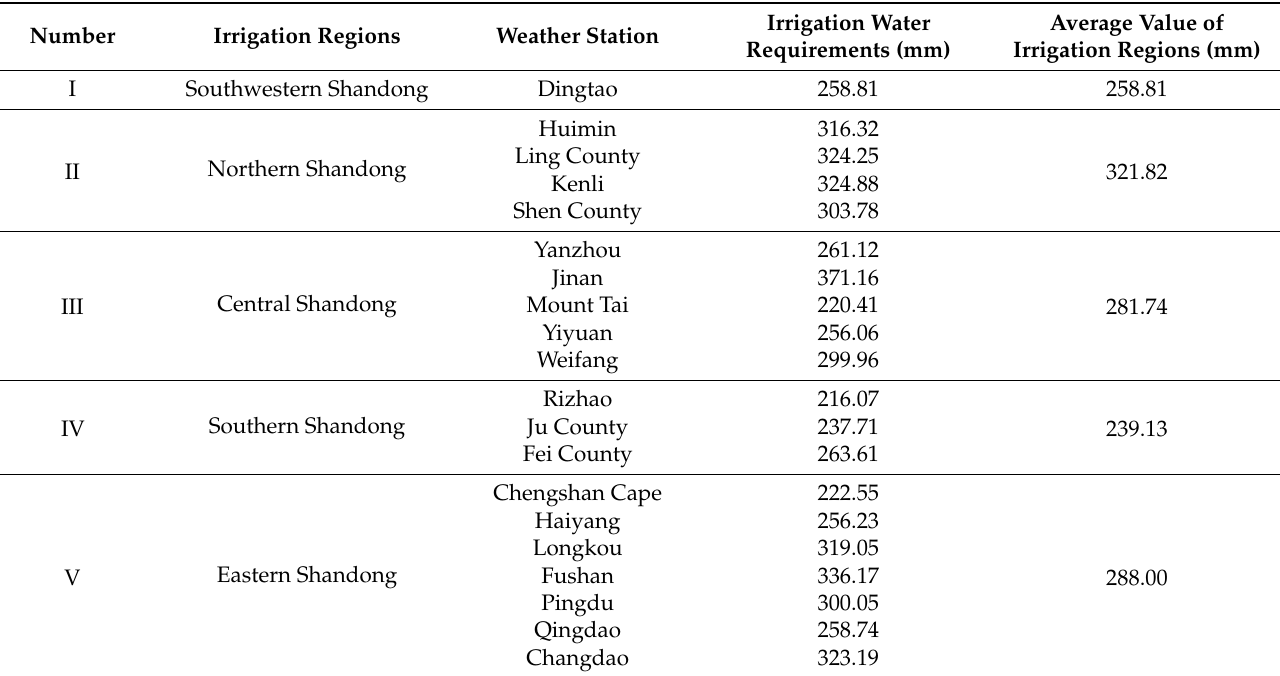
Table 4. The multi-year average irrigation water requirements of winter wheat from 1968 to